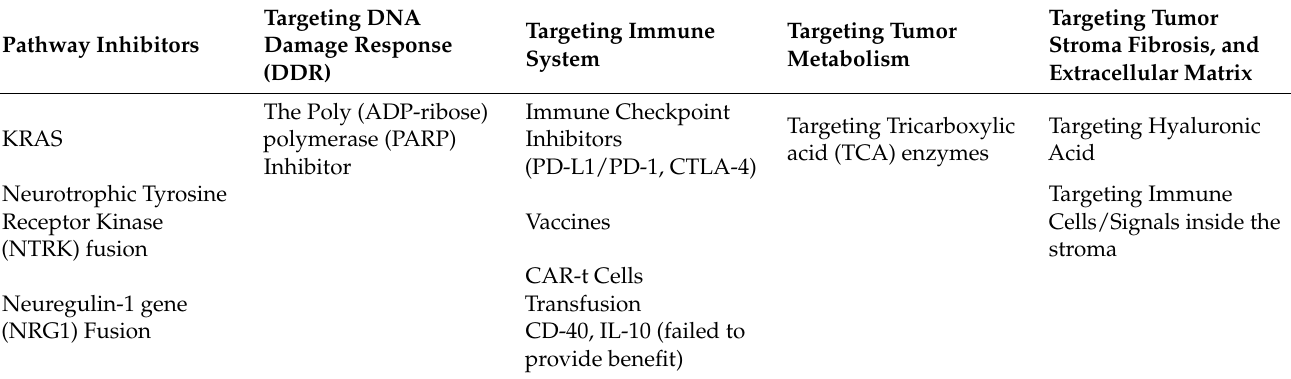
Table 1. A panoramic of novel treatments in development for PC.